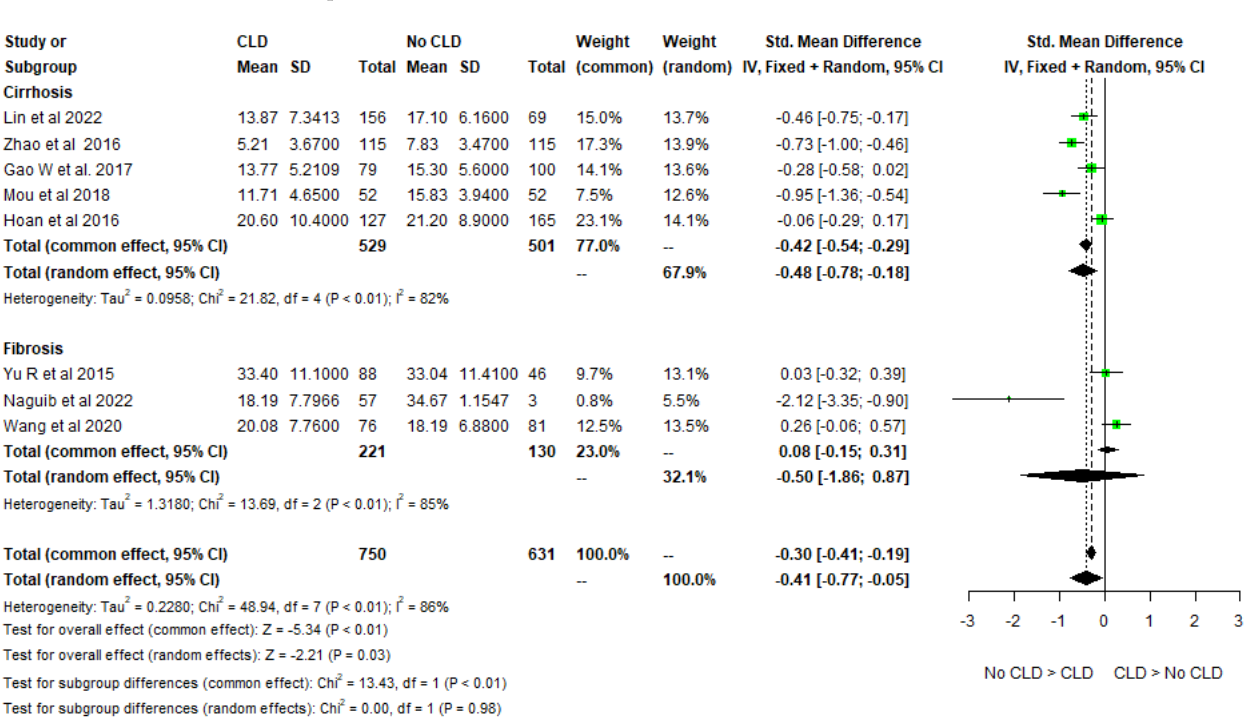
Figure 5. Forest plots of vitamin D levels in CHB patients with absence or presence of cirrhosis [9,21,22,26,37]/fibrosis [30,35,48].